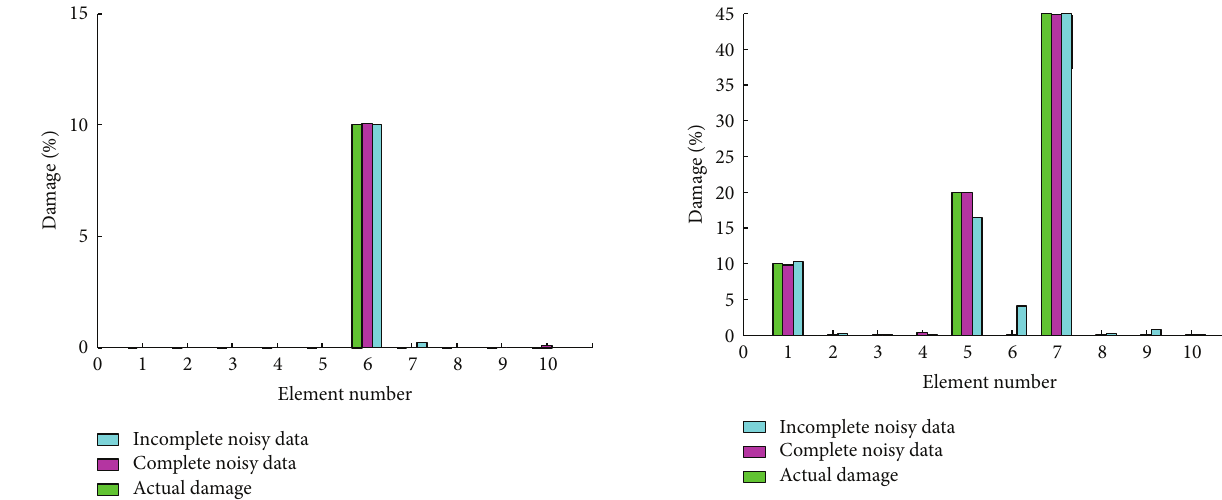
Figure 4: Damage distribution of cantilever beam using the com- plete and incomplete noisy data in Scenario 1.